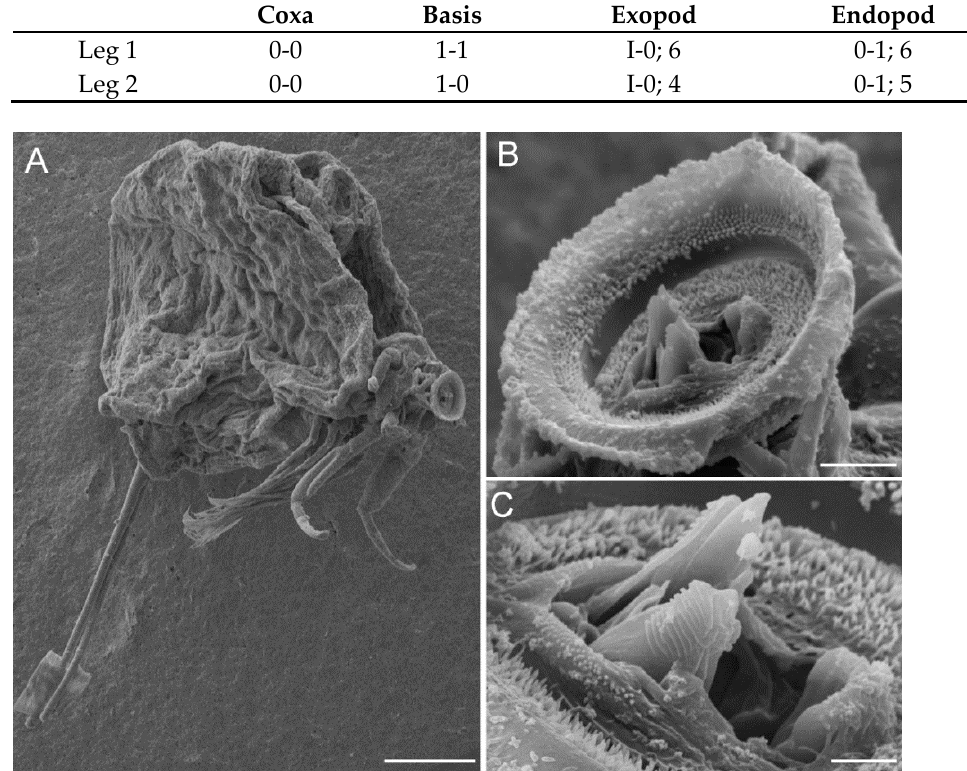
Figure 4. Scanning electric micrographs of Choniomyzon taiwanensis n. sp. ( A ) Adult female, right lateral; ( B ) oral region, postero-ventral; ( C ) tip of the mandible (MD) projects from the distal opening of oral cone (OC). Scale-bars: ( A ), 100 µm; ( B ), 10 µm; ( C ), 3 µm.